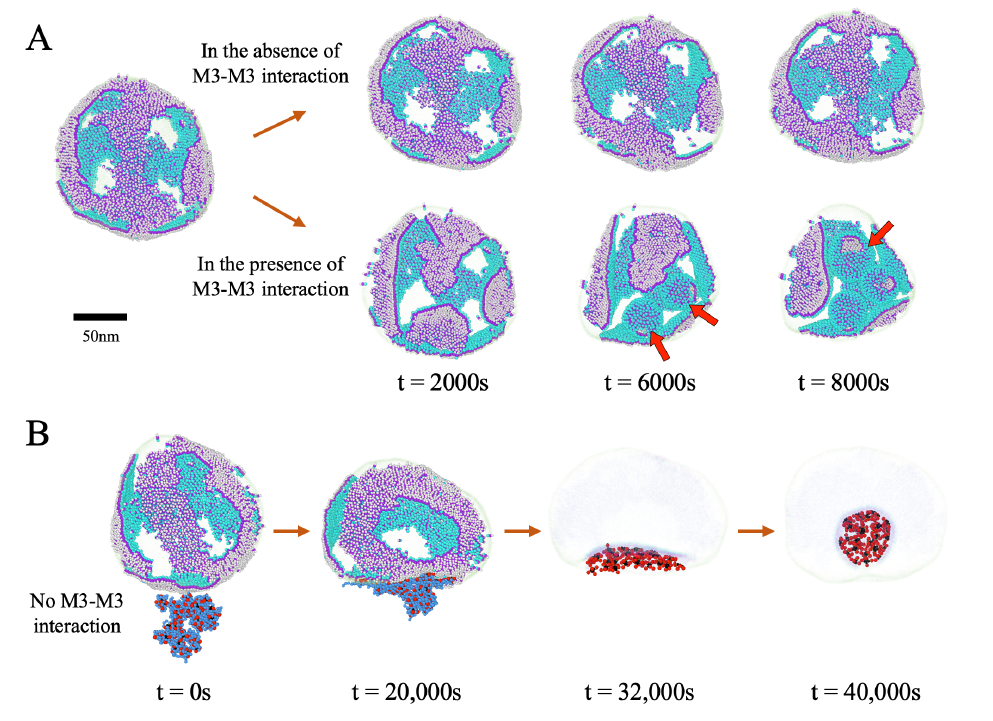
Figure 8. ( A ) Snapshots of the simulations of the distribution of the M proteins embedded in the ERGIC membrane as a function of time. Initially, the M proteins are randomly distributed in the ERGIC membrane. The first snapshot at the left illustrates the distribution of the M proteins in ERGIC = 1 and (cid:101) = 0. where the proteins and membrane have been relaxed for 16,000 s with (cid:101) M M 3 M 3 2 M 2 As a result of diffusion, the M proteins have formed a branched-like pattern. In the absence of the M3–M3 interaction, the branched-like pattern does not change (top row). However, with increasing the endodomain–endodomain attractive interaction (cid:101) M , the connected patches of M proteins begin 3 M 3 to aggregate into circular domains (bottom row, indicated with red arrows), which will eventually bud into empty vesicles. Note that the M proteins cover half of the surface of ERGIC, i.e., the M protein fraction is f = 50% during the simulations; ( B ) snapshots of the simulations of the RNP budding from ERGIC. Initially, the randomly distributed M proteins form a branched-like pattern on the surface of ERGIC in the absence of the endodomain interaction. However, the interaction with RNP results in the aggregation of the proteins in the vicinity of RNP and the formation of the envelope enclosing RNP. The branched-like distribution is obtained by relaxing ERGIC and the M proteins for 16,000 s. The RNP structure is obtained by relaxing N proteins (25 µM) and RNA for 8000 s. RNA is modeled as a branched polymers with the charge density Z g = − 2 and the number of branch points N = 30. The comparison of ( A , B ) reveals that RNP can mediate the interaction between the endodomains giving rise to a preferred curvature between M